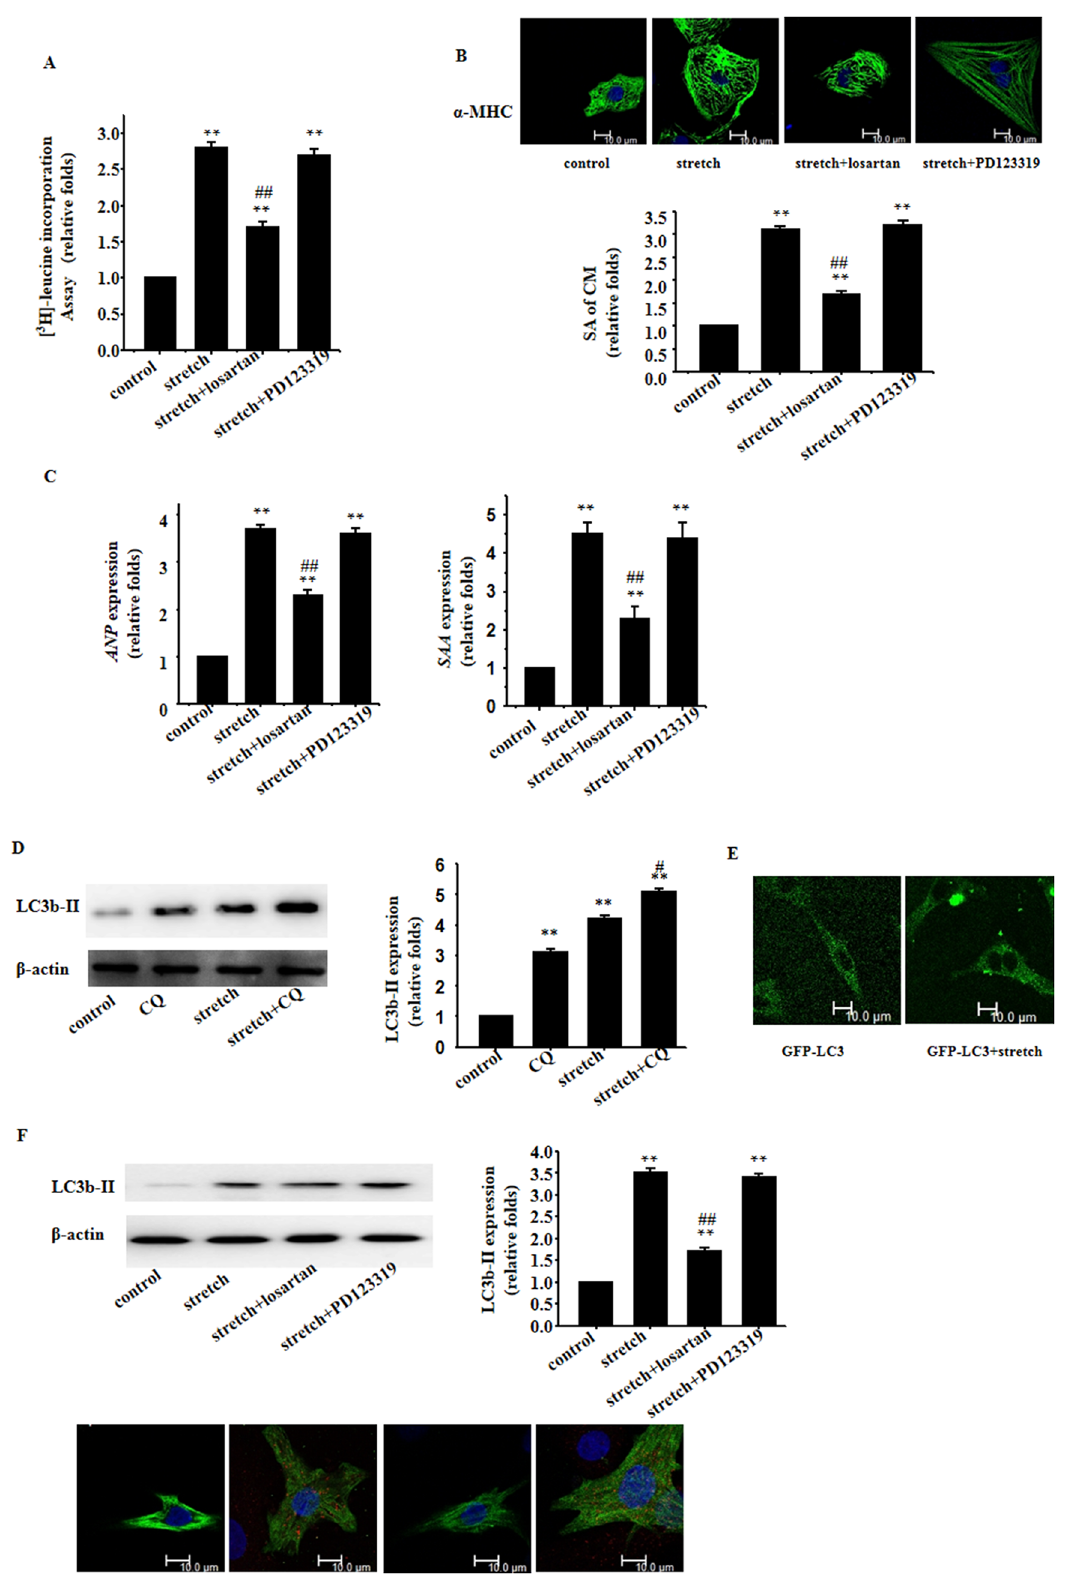
Figure 1. Involvement of AT 1 receptor in mechanical stretch-induced cardiomyocyte hypertrophic and autophagic responses. Cultured cardiomyocytes of neonatal rats were treated with vehicle (Control), stretch in the absence or presence of Losartan (10 2 6 mol/L) or PD123319 (10 2 6 mol/L); A : [ 3 H]-Leucine incorporation in cardiomyocytes; B : Cardiomyocyte morphology and size; cardiomyocytes were subjected to